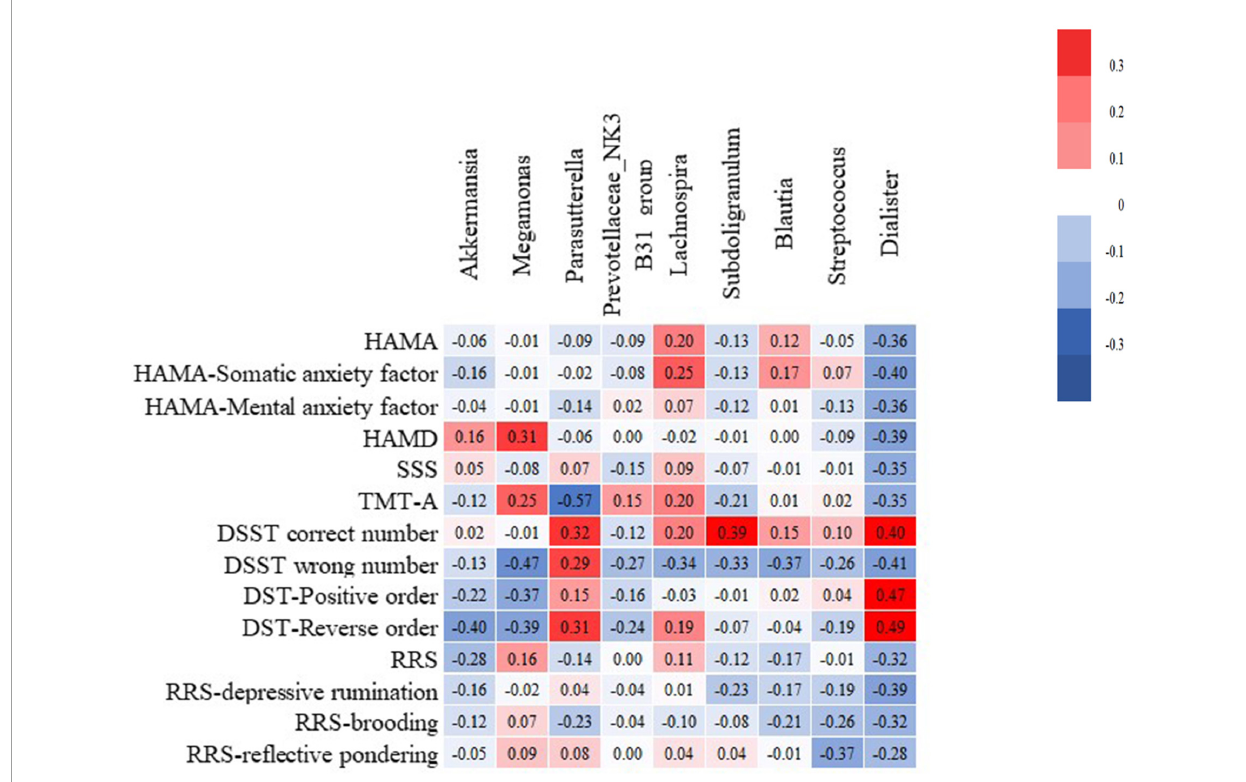
FIGURE7 Analysis of the correlation between the abundance of key bacterial genera and clinical symptoms. A positive correlation is red, and the deeper the red, the higher the positive correlation. A negative correlation is blue, and the deeper the blue, the higher the negative correlation. The figure in the box is the correlation index r . RRS-Depressive rumination RRS-Brooding RRS- Reflective pondering.